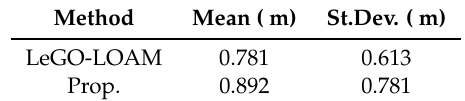
Table 4. Comparison